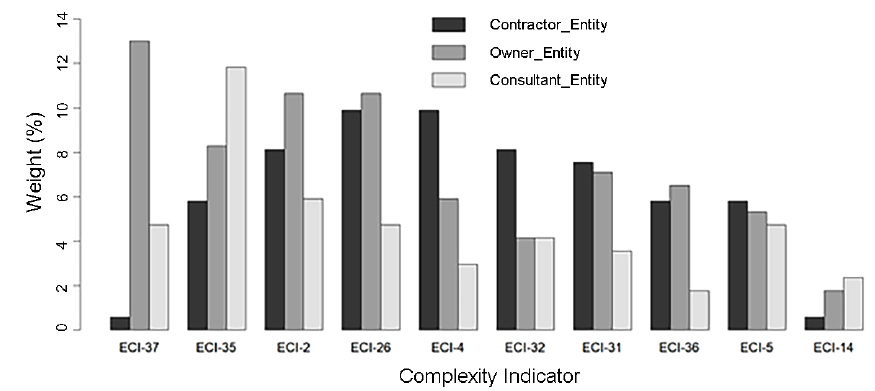
Figure 4. Comparison of the weights associated with the shared ECIs among primary project